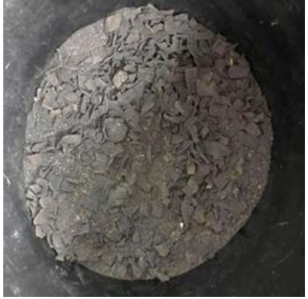
Figure 9. Soil sample after 21 days of soil composting.